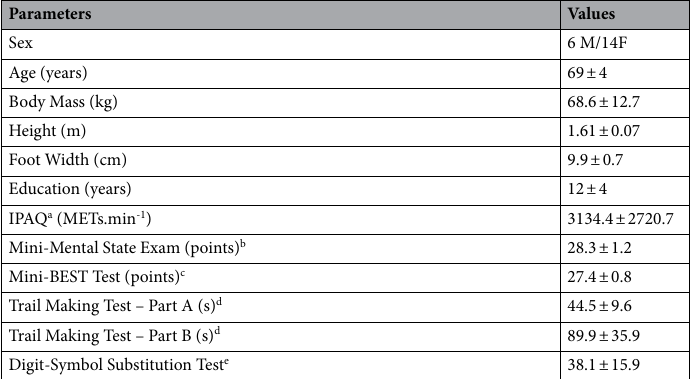
Table 1. Mean and standard deviation (±) of the participants’ physical, behavioral, and cognitive variables ( n = 20). a Cut-off points for physical activity level: high = at least 3.000 METs.min -1 per week, moderate = at least 600 METs.min -1 per week, and low = less than 600 METs.min -1 per week 42 . b Scores close to 30 points (maximum punctuation) indicate the absence of cognitive deficit. Cut-off points based on time of education in a Brazilian population: No schooling = 20 points; 1–4 years of schooling = 25 points; 5–8 years of schooling = 26 points; 9–11 years of schooling = 28 points; More than 11 years of schooling = 29 points 35 . Twelve of the twenty participants scored in the respective cut-off for their education level or higher, while the others 8 scored a maximum of 2 points below the indicated. c Scores close to 28 points (maximum punctuation) indicate a low risk for falls 36 . d Score stratification is based on age and time of education 37 . None of the participants scored both parts of the test in the expected stratification. e Number of correct responses completed in 90 seconds 38